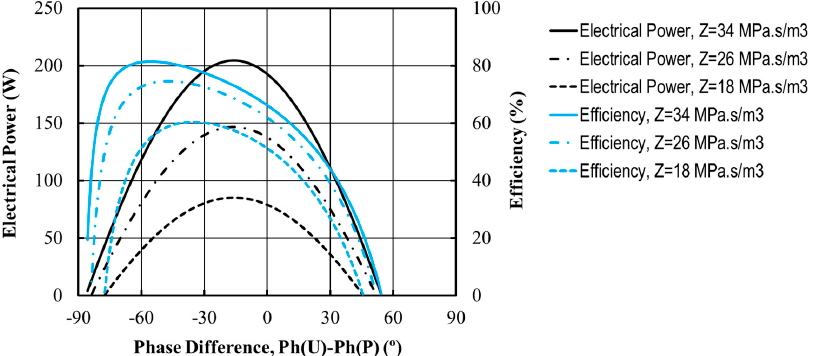
Figure 2. LA electrical power generated and efficiency at push-pull coupling for different acoustic impedance and phase difference.